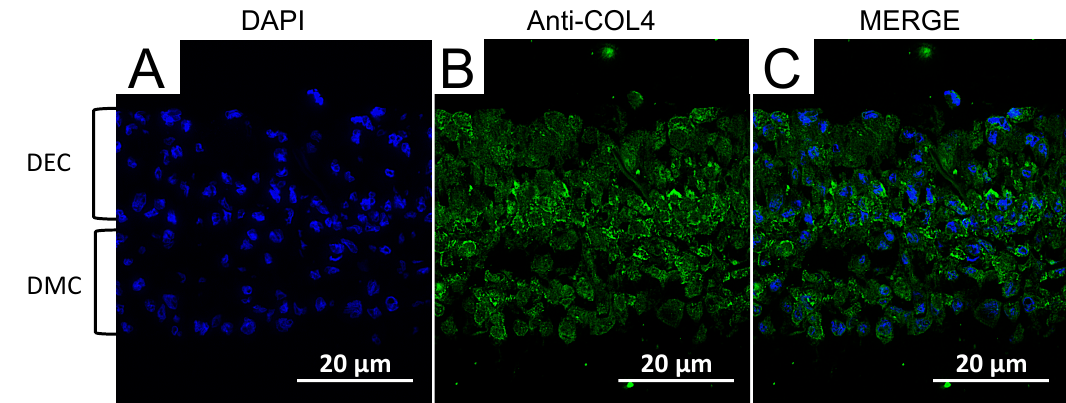
Figure 8. Fluorescence microscopic observation of a CC sheet (×200). DAPI (blue) was used to stain nuclei ( A ). COL4 was stained with a specific antibody. COL4-expressing cells (green) were identified around the border of DEC and DMC layers ( B , C ). Scale bars = 20 μ m.